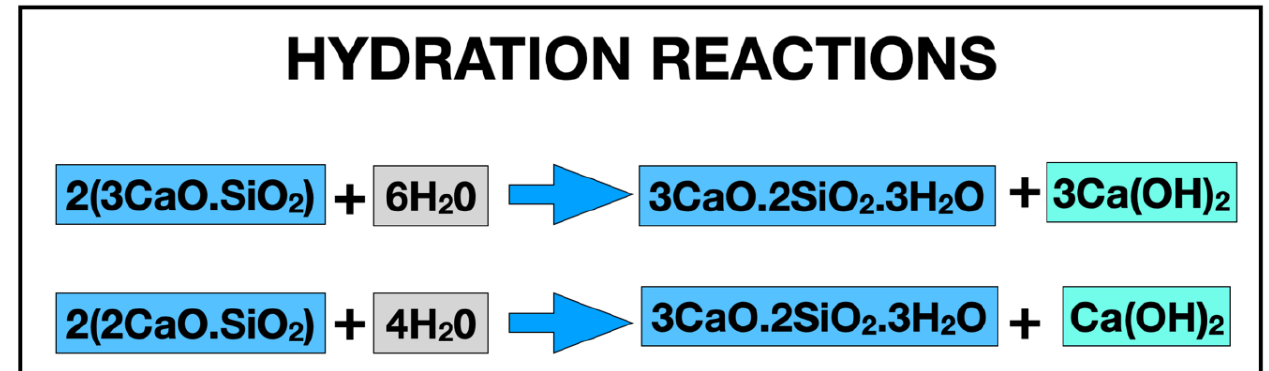
Figure 1. Setting reaction of CSBS consisting of two hydration reactions.